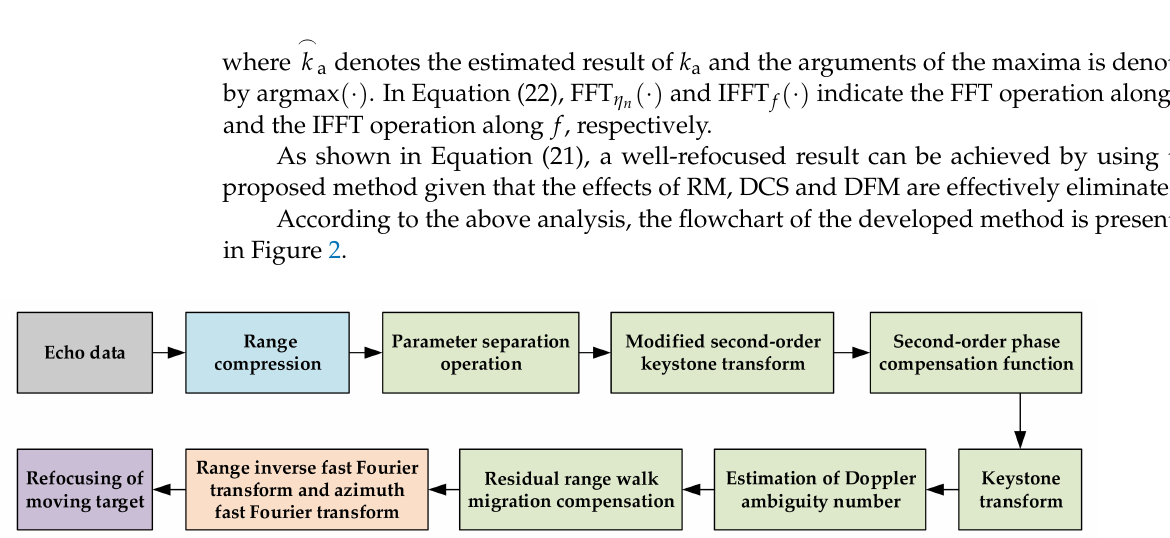
Figure 2. Flowchart of the developed